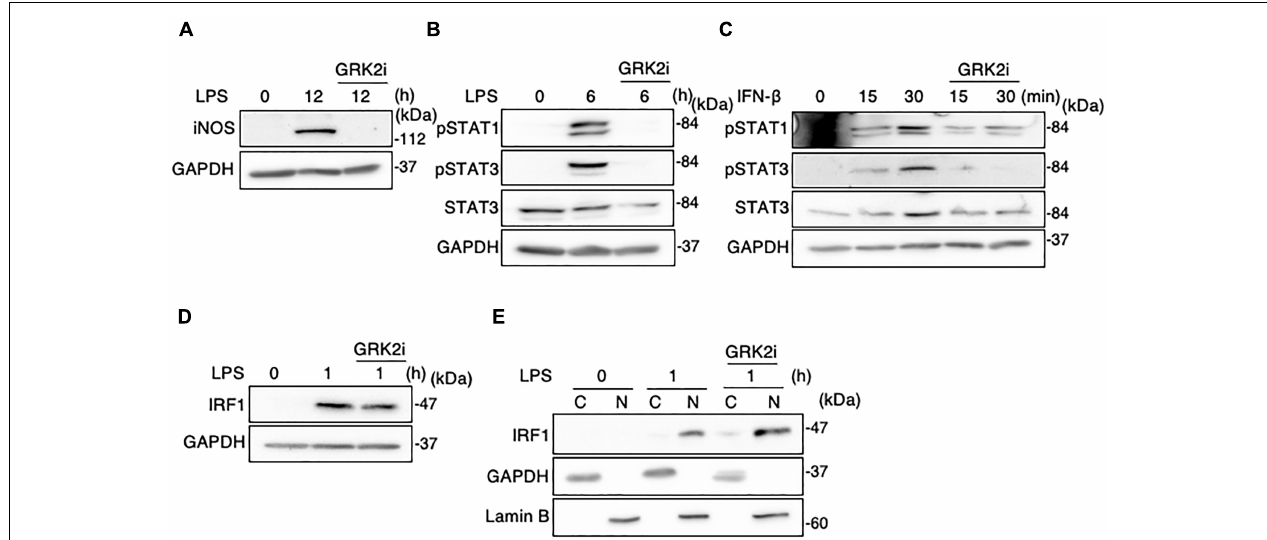
FIGURE 10 | Effect of GRK2 inhibitor treatment on iNOS expression, STAT1/3 activation, and IRF1 activation in microglial cells. GRK2 inhibitor at a concentration of 10 µ M was added at 30 min before challenge with 100 ng/ml LPS or 10 ng/ml IFN- β . (A) Expression of iNOS protein before and 15 h after LPS application. (B) STAT1 and STAT3 phosphorylation before and 6 h after LPS application. (C) STAT1 and STAT3 phosphorylation before and 15–30 min after IFN- β supplementation. (D) Expression of IRF1 expression before and 1 h after LPS application. (E) Cytoplasmic (C) and nuclear (N) fractions were isolated, and then changes in IRF1 levels in each fraction before and 1 h after LPS application was tracked by Western blot analysis. GAPDH served as loading control and lamin B was used as a nuclear marker. Shown are representative Western blots from three independent experiments in which the same results were obtained.